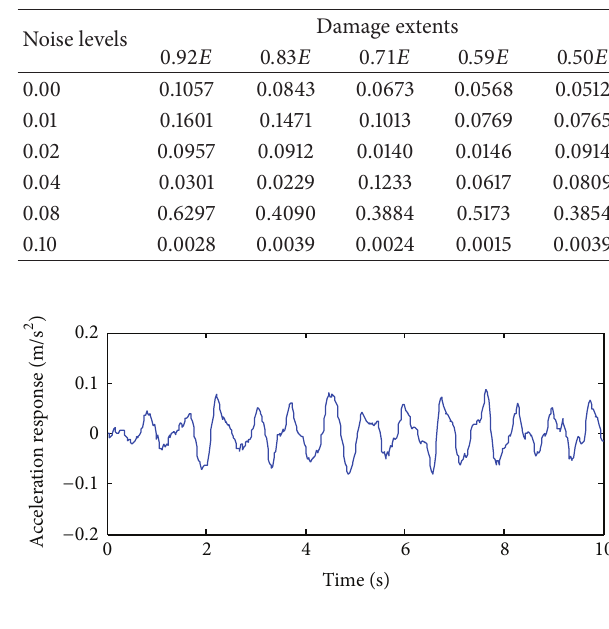
Table 10: The MAC values of acceleration damage parameter vector extracted from different load cases.